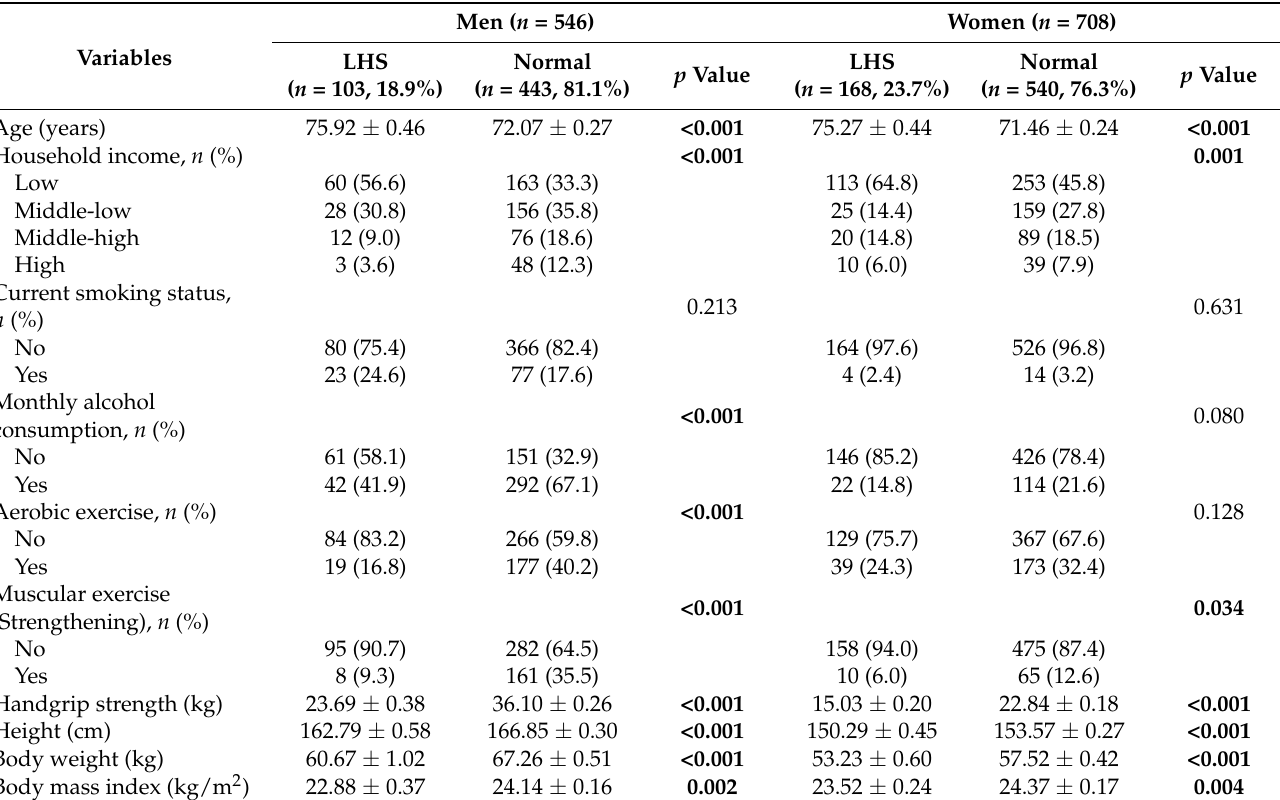
Table 1. Baseline characteristics of the participants with low handgrip strength or normal handgrip strength in men and